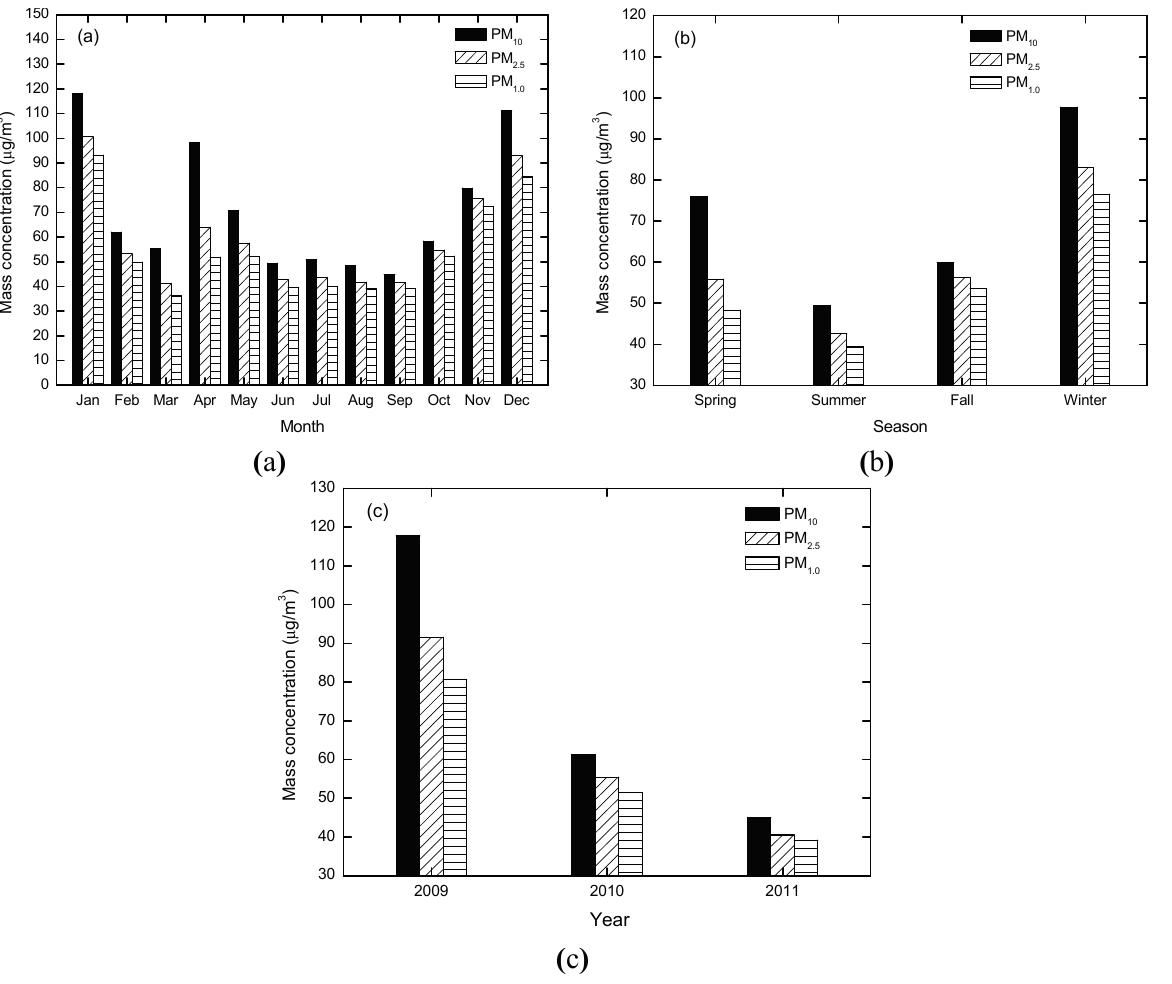
Figure 1. Monthly ( a ), seasonal ( b ) and inter-annual ( c ) average mass concentration variations of PM 10 , PM 2.5 and PM 1.0